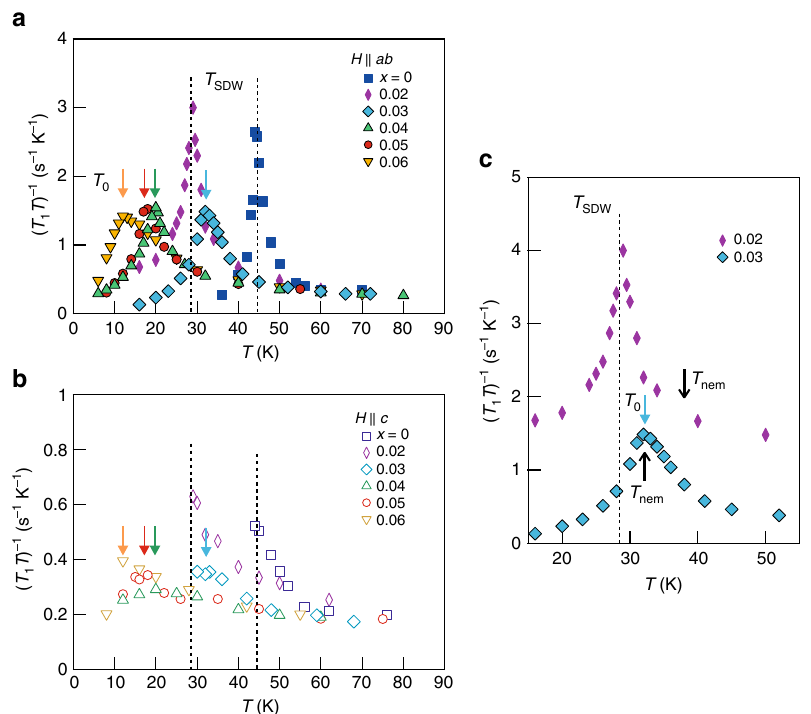
Fig. 4 Spin – lattice relaxation rates as a function of temperature and doping. a , b The spin – lattice relaxation rate divided by temperature, ( T 1 T ) − 1 , measured at 9.1 T perpendicular and parallel to c , respectively. For x = 0 and 0.02, the SDW transitions were identi fi ed by the sharp peak of ( T 1 T ) − 1 at T SDW . Similar sharp transitions were observed for larger dopings ( x ≥ 0.03) at temperatures denoted by T 0 , without an indication of long range SDW order. The comparison between a and b reveals that the strong anisotropy of spin fl uctuations persists up to x = 0.06. c Comparison between the ( T 1 T ) − 1 data for x = 0.02 and x = 0.03 obtained with H || ab . The data for x = 0.02 are offset vertically for clarity. It shows that T 0 for x = 0.03 is higher than T SDW for x = 0.02, but nearly coincides with T nem obtained by resistivity (see Fig.